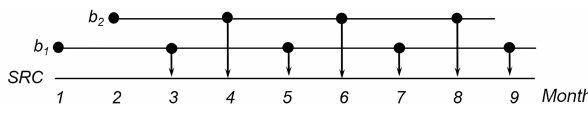
Figure 3. Schematic illustration of MAIAC dynamic SRC retrievals featuring two independent lines of update, b 1 and b 2